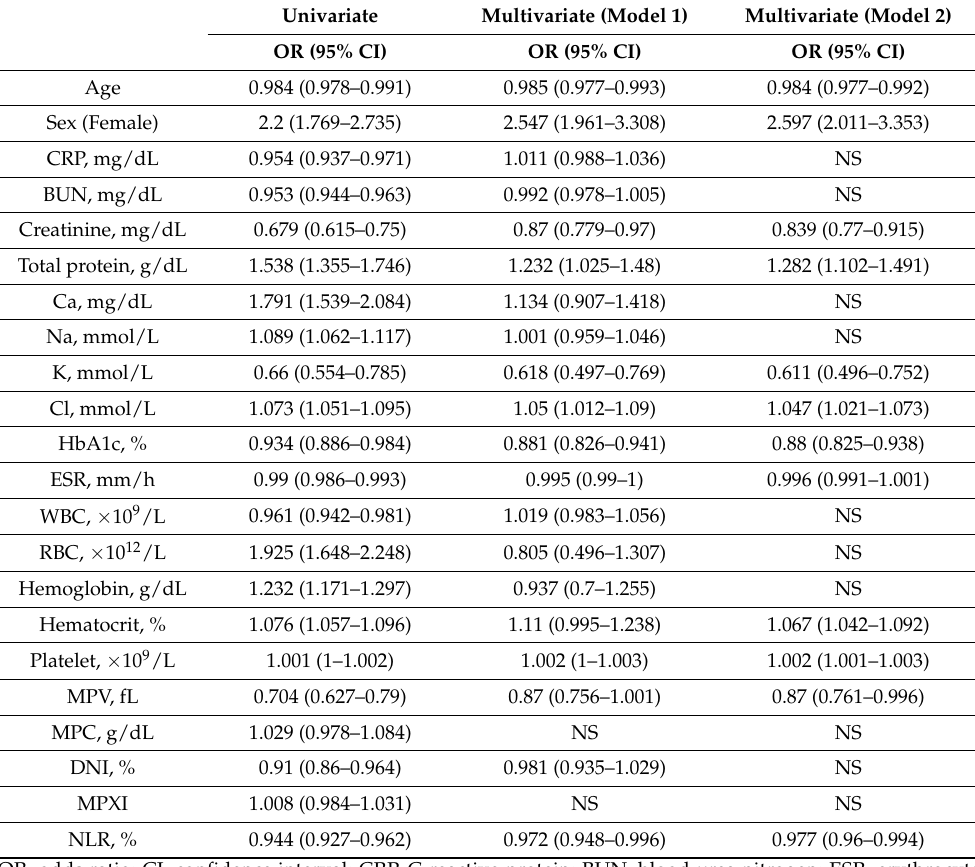
Table 3. Feature selection of prediction model for osteomyelitis using backward stepwise logistic regression.